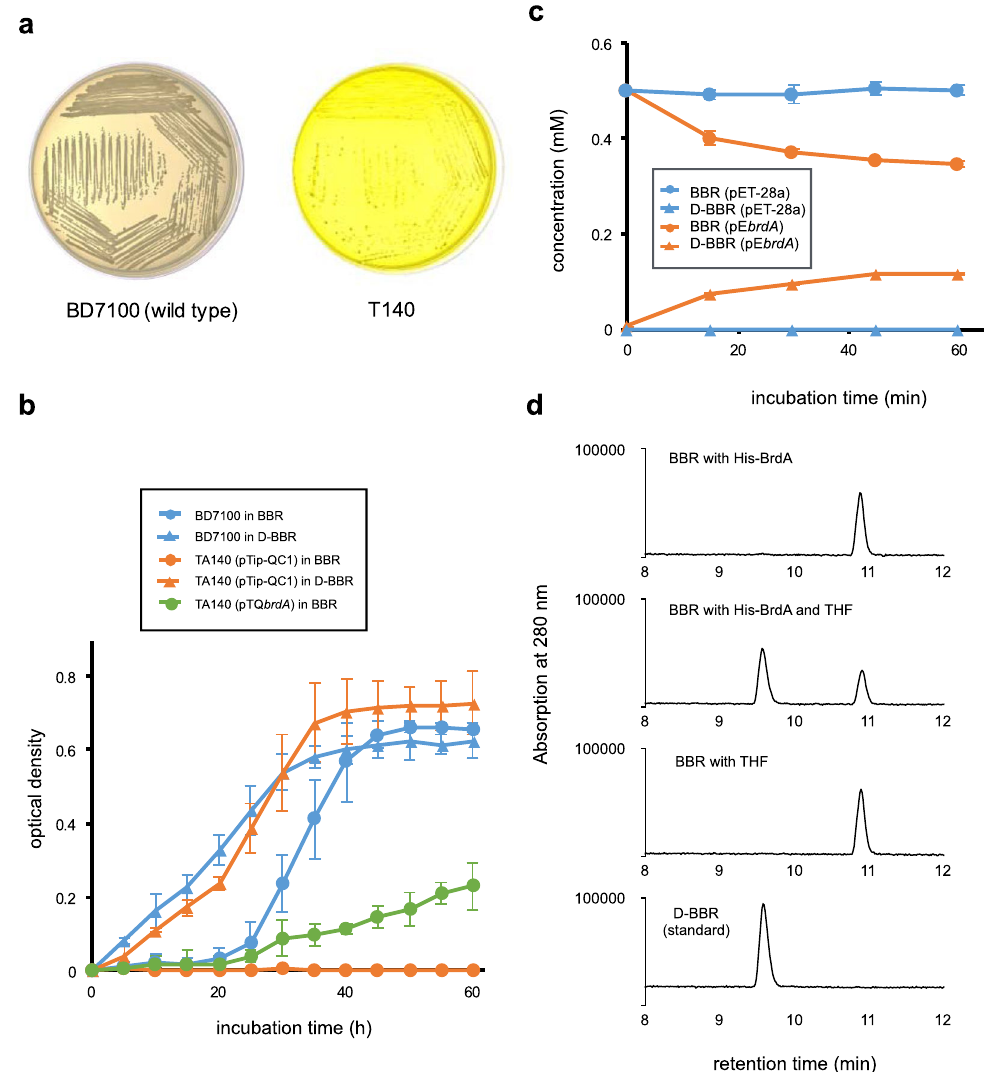
Figure 2. Characterization of BrdA. ( a ) Growth of BD7100 and the transposon mutant TA140 for 5 days on LB medium containing 0.5 mM BBR. Compared with wild-type BD7100 strains, the BBR-derived yellow color in the medium did not disappear with TA140. ( b ) The growth of BD7100 and TA140 in minimal media containing BBR (circles) or D-BBR (triangles). The blue and orange lines indicate growth of BD7100 and TA140 harboring pTip-QC1 (vector control), respectively. The green line indicates growth of TA140 cells harboring pTQ brdA . Each value is the average of at least three measurements. The vertical lines indicate the standard deviations from the means. The addition of the brdA gene to the TA140 strain restored growth in BBR. ( c ) Crude-extract assay of BBR. The blue and orange lines indicate crude extracts of E. coli BL21 (DE3) harboring pET-28a and pE brdA , respectively. Circles and triangles indicate concentrations of BBR and D-BBR, respectively. Each value is the average of at least three measurements. The vertical lines indicate the standard deviations from the means. ( d ) HPLC chromatograms (UV 280 nm) of the reaction at 10 min in the purified-enzyme assay. The D-BBR standard is shown at the bottom. The production of D-BBR is observed only in the presence of THF with His-